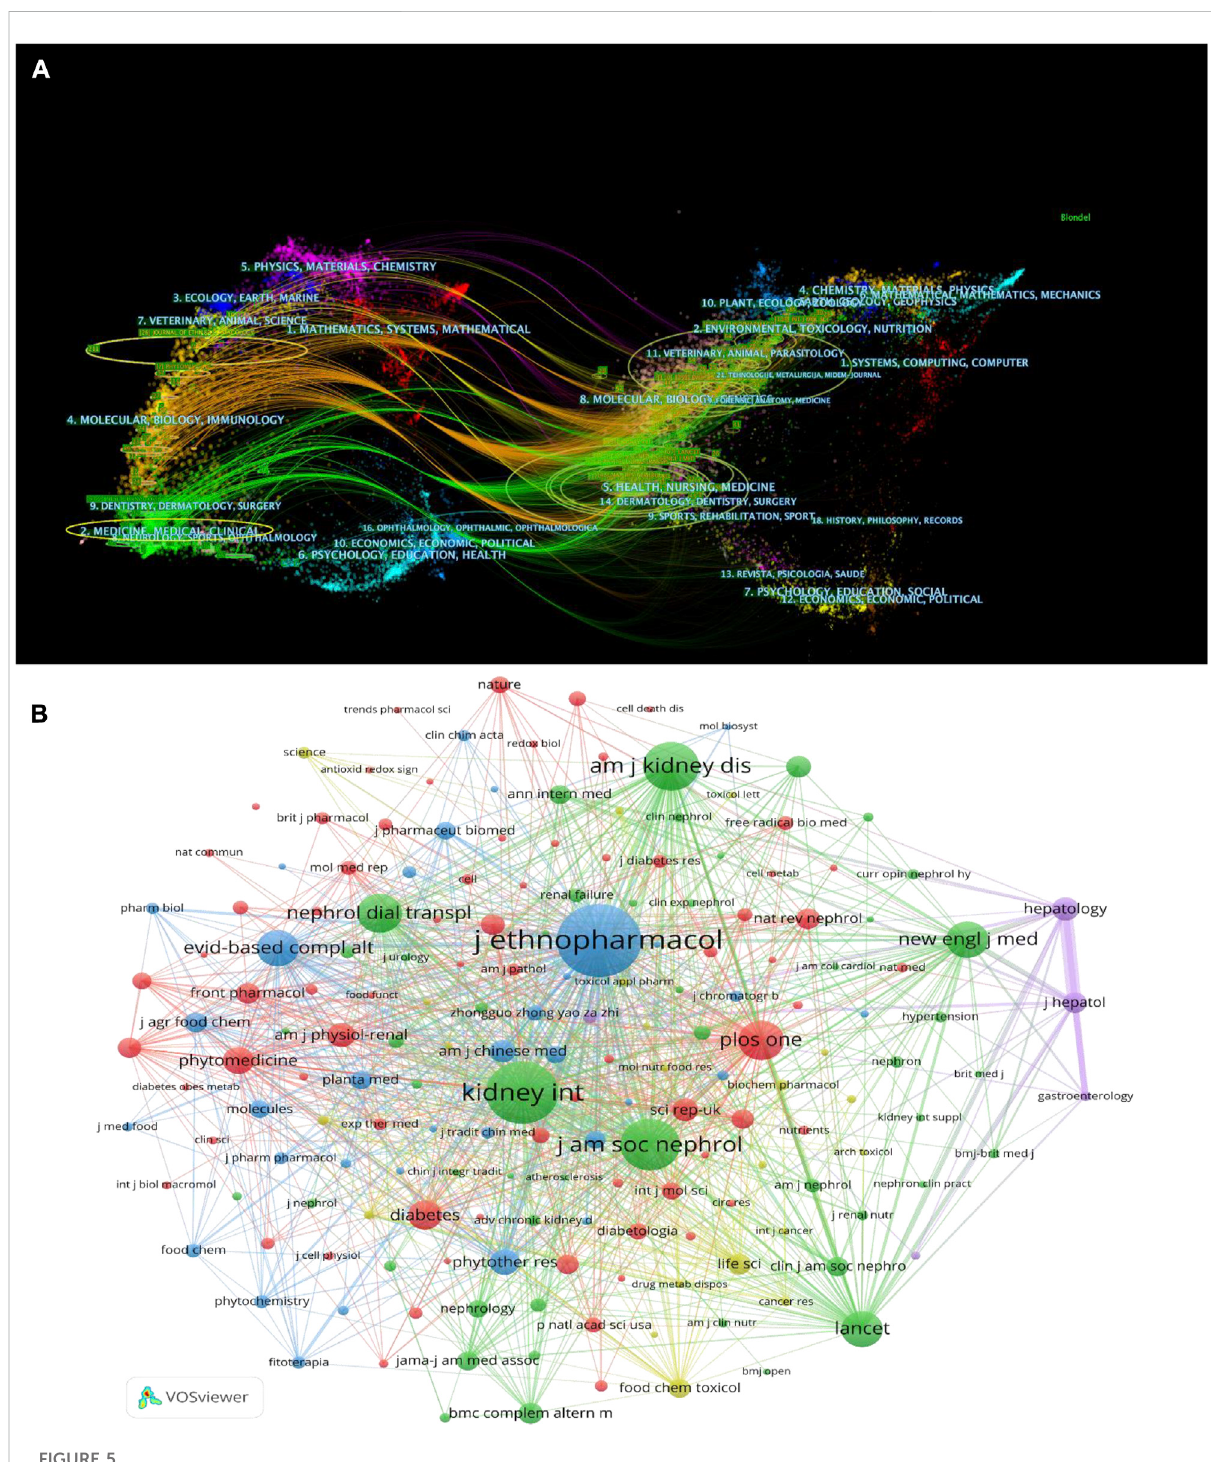
FIGURE 5 (A) The dual-map overlay of journals on herbal medicine for chronic kidney disease. (B) Citations journals co-occurrence